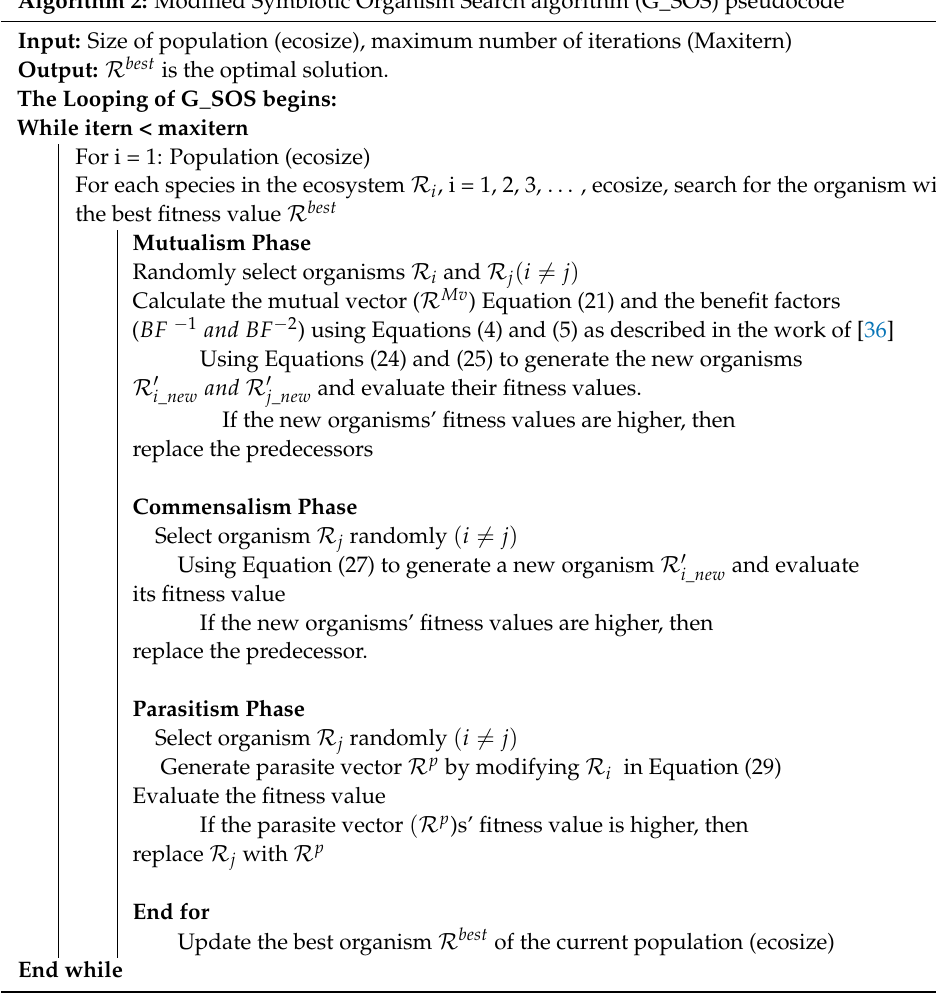
Algorithm 2: Modified Symbiotic Organism Search algorithm (G_SOS)